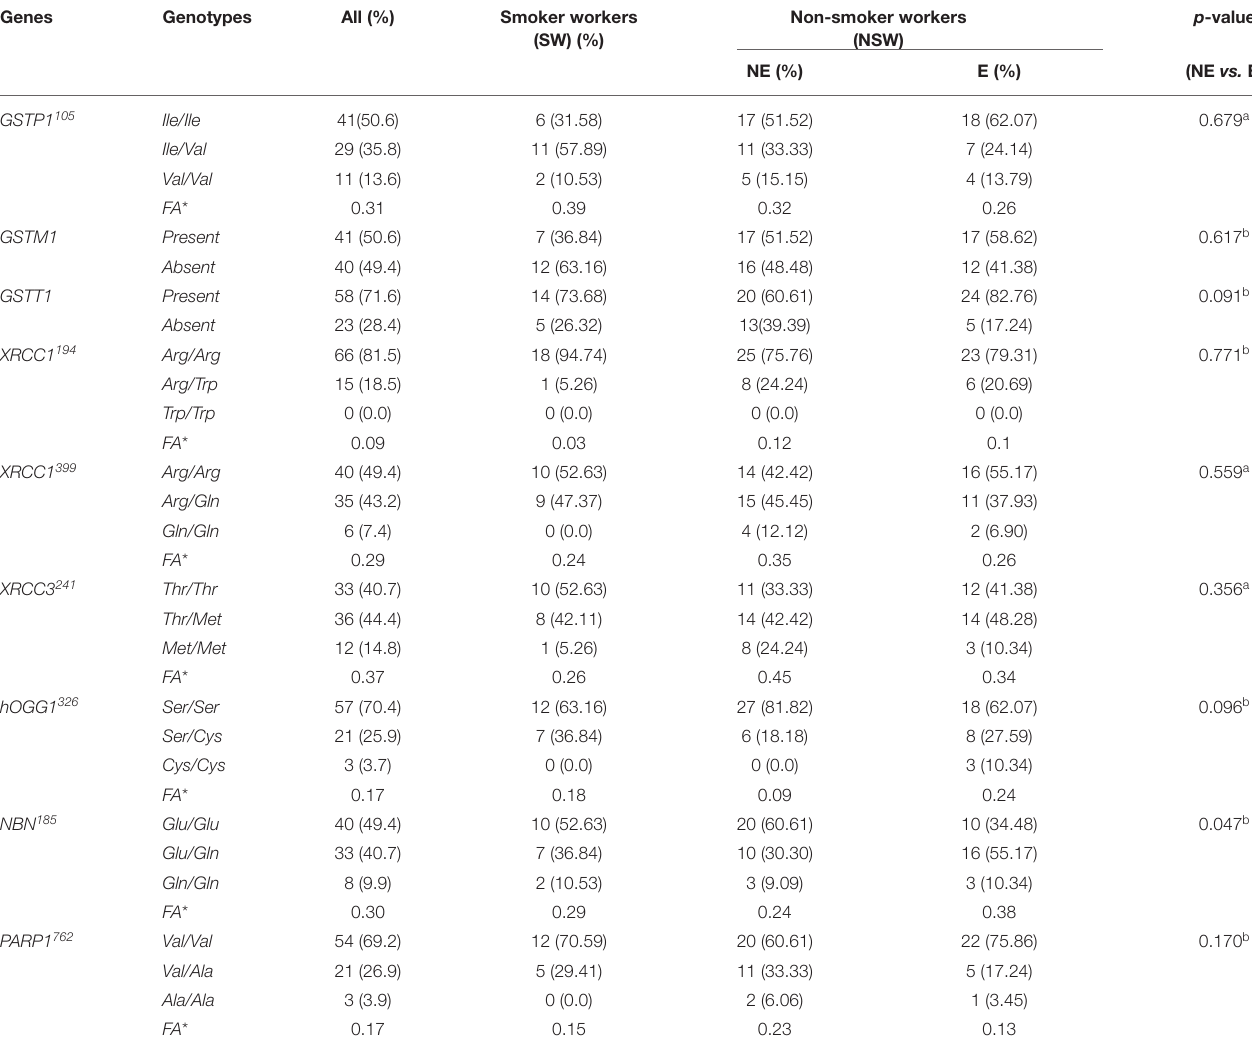
TABLE 4 | Frequency of metabolism and DNA repair genotypes in the studied groups. Genes